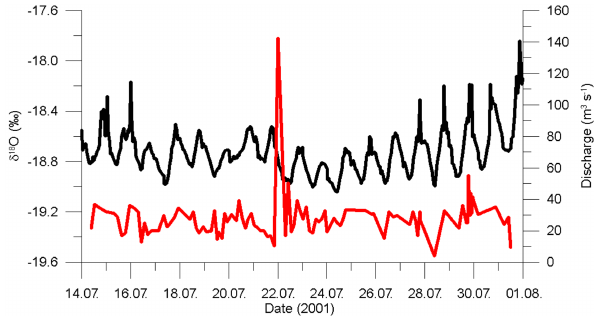
Figure 4. Time series of δ 18 O (red curve) and discharge (black curve) in the Kuannersuit Glacier river during the period 14–31 July